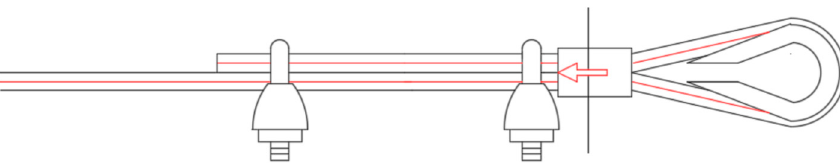
Figure 36. How the ferrule modifies the load centering on the two clips, compared with the load transfer scheme of Figure 25.